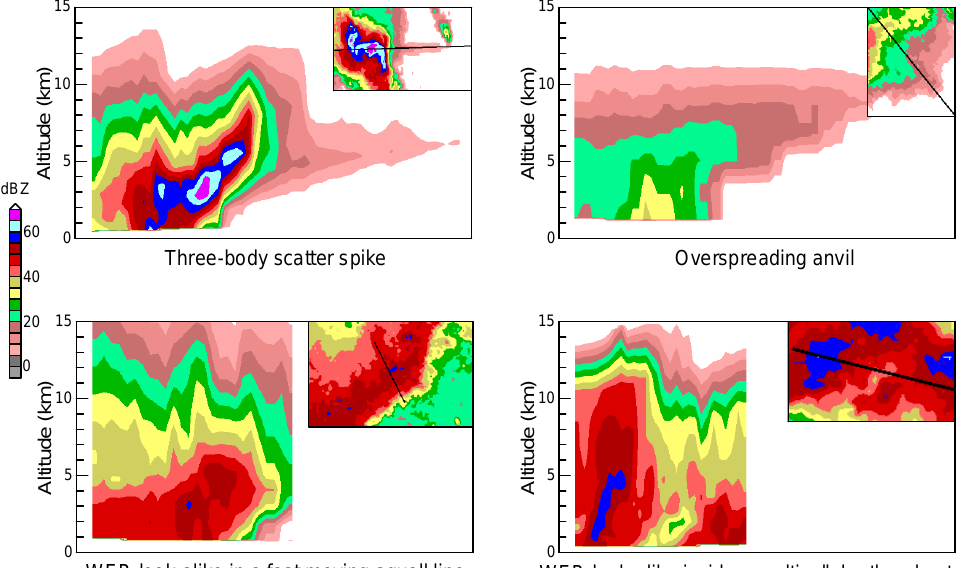
Figure 6. Examples of WER